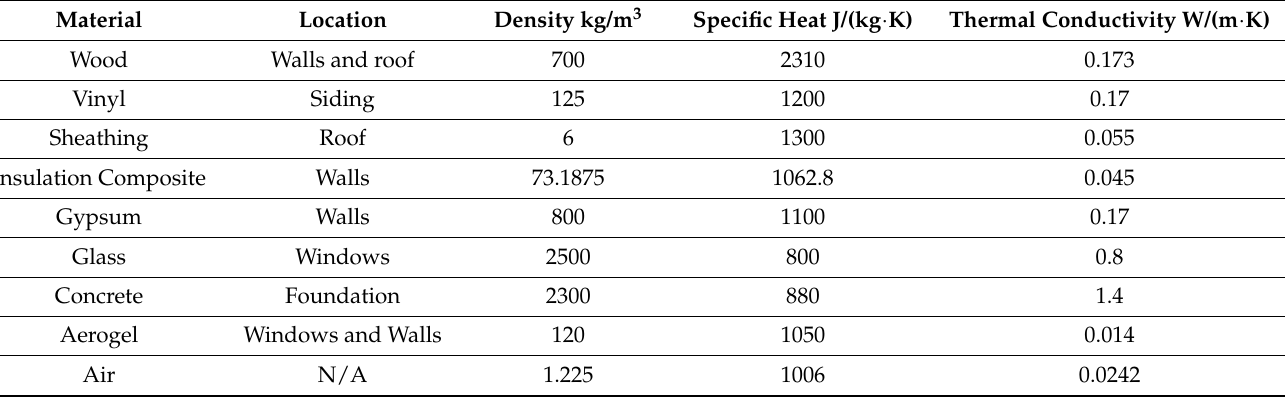
Table 3. Simulation materials.